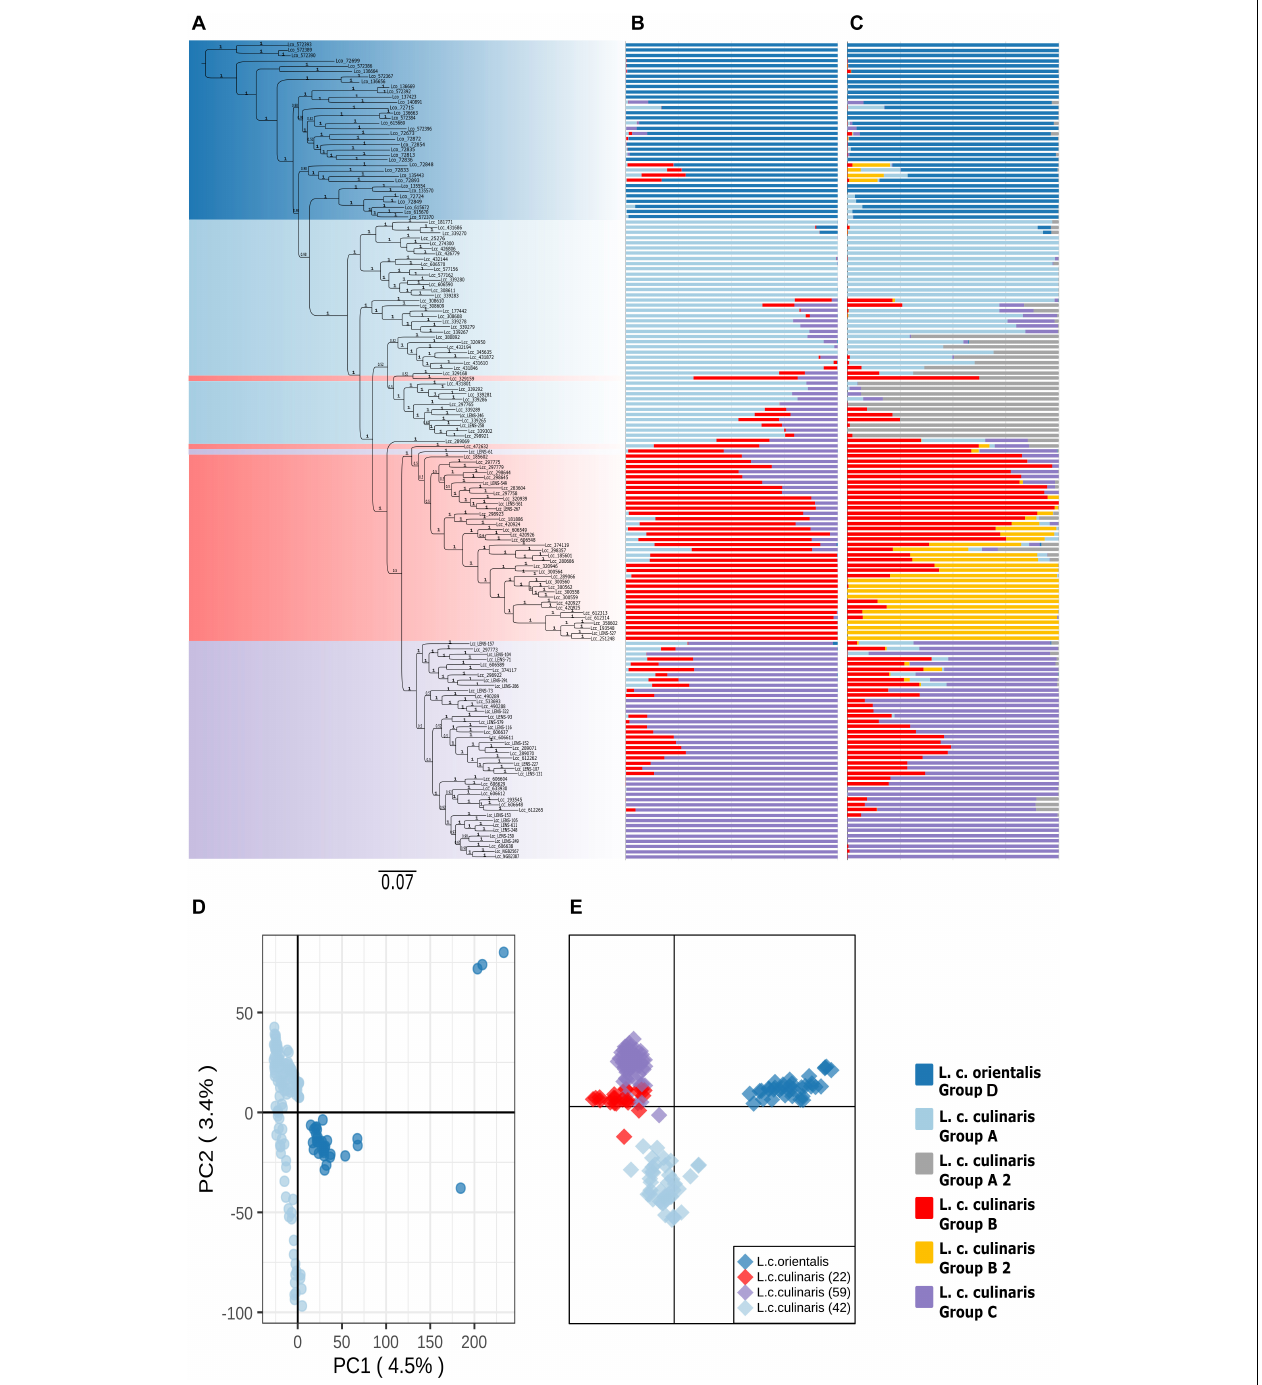
FIGURE 2 | Phylogeny and population structure analysis of 157 accessions of L. culinaris (wild orientalis and cultivated culinaris ) based on 87,647 SNPs revealed by GBS. (A) MrBayes generated phylogeny. (B) STRUCTURE K = 4 model. (C) STRUCTURE K = 6 model. (D) First and second principal components of a PCA. (E) DAPC